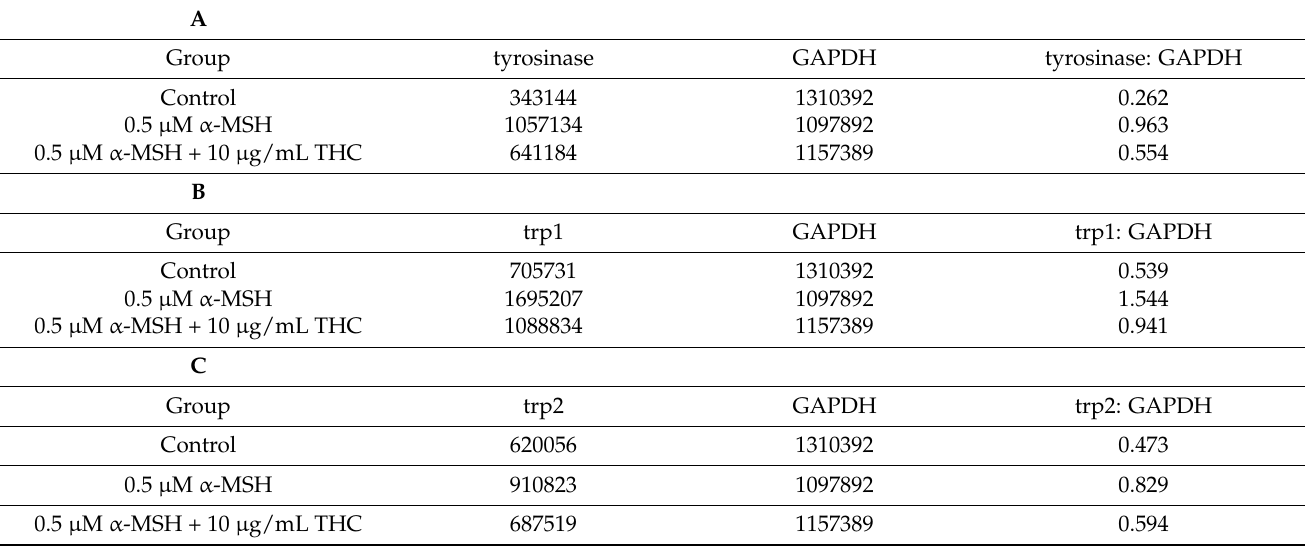
Figure 4. Anti-melanogenic effect of THC on the B16F10 cells. ( A ) Effects of THC on the viability of B16F10 melanoma cells after 48 h treatment. ( B ) Melanin content comparison between control group, cells treated with 0.5 µM MSH, and 0.5 µM α -MSH with 1 µ g/mL and 10 µ g/mL THC, respectively after B16F10 cells were cultured for 48 h. ( C ) Cellular tyrosinase (TYR) activity. ( D ) Western blotting analysis of protein expressions for TYR, tyrosinase related protein 1 (TRP1), tyrosinase related protein 2 (TRP2), and Glyceraldehyde 3-phosphate dehydrogenase (GAPDH) as the internal reference in B16F10. Results are expressed as mean SD ( n = 3). *** p < 0.001 compared to group treated with 0.5 µM α -MSH. Table 2. Quantitative results of the grey values from the Western blot analysis. Grey values for tyrosinase ( A ); trp1 ( B ); trp2 ( C ). GAPDH acted as the internal